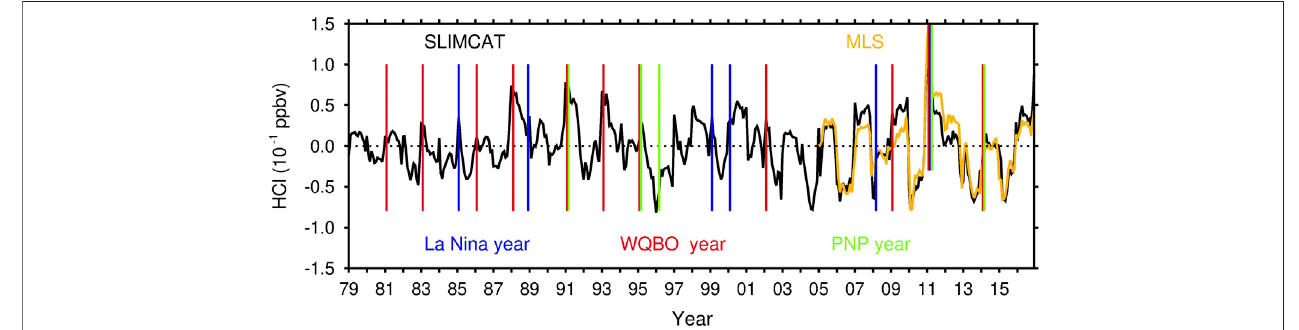
FIGURE6 | Time seriesofHCl anomaly(units:10 − 1 ppbv) from 1979 to2016based onSLIMCAT model simulations (blackline). Also shown are theHCl variations from 2005 to 2016 from MLS measurements (yellow line). Blue, red and green vertical lines represent La Niña, the west phase of the QBO (WQBO) and positive SST anomalies in the North Paci fi c (PNP), respectively. Note that HCl exhibits an increasing trend from 1979 to 1997 and a decreasing trend from 1997 to 2016. To remove the effect of HCl trends on its anomalies, the linear trends of HCl are removed before and after 1997. The HCl variations are averaged in the region 30 – 58 ° N and 10 – 50 hPa and the seasonal cycle has been removed.